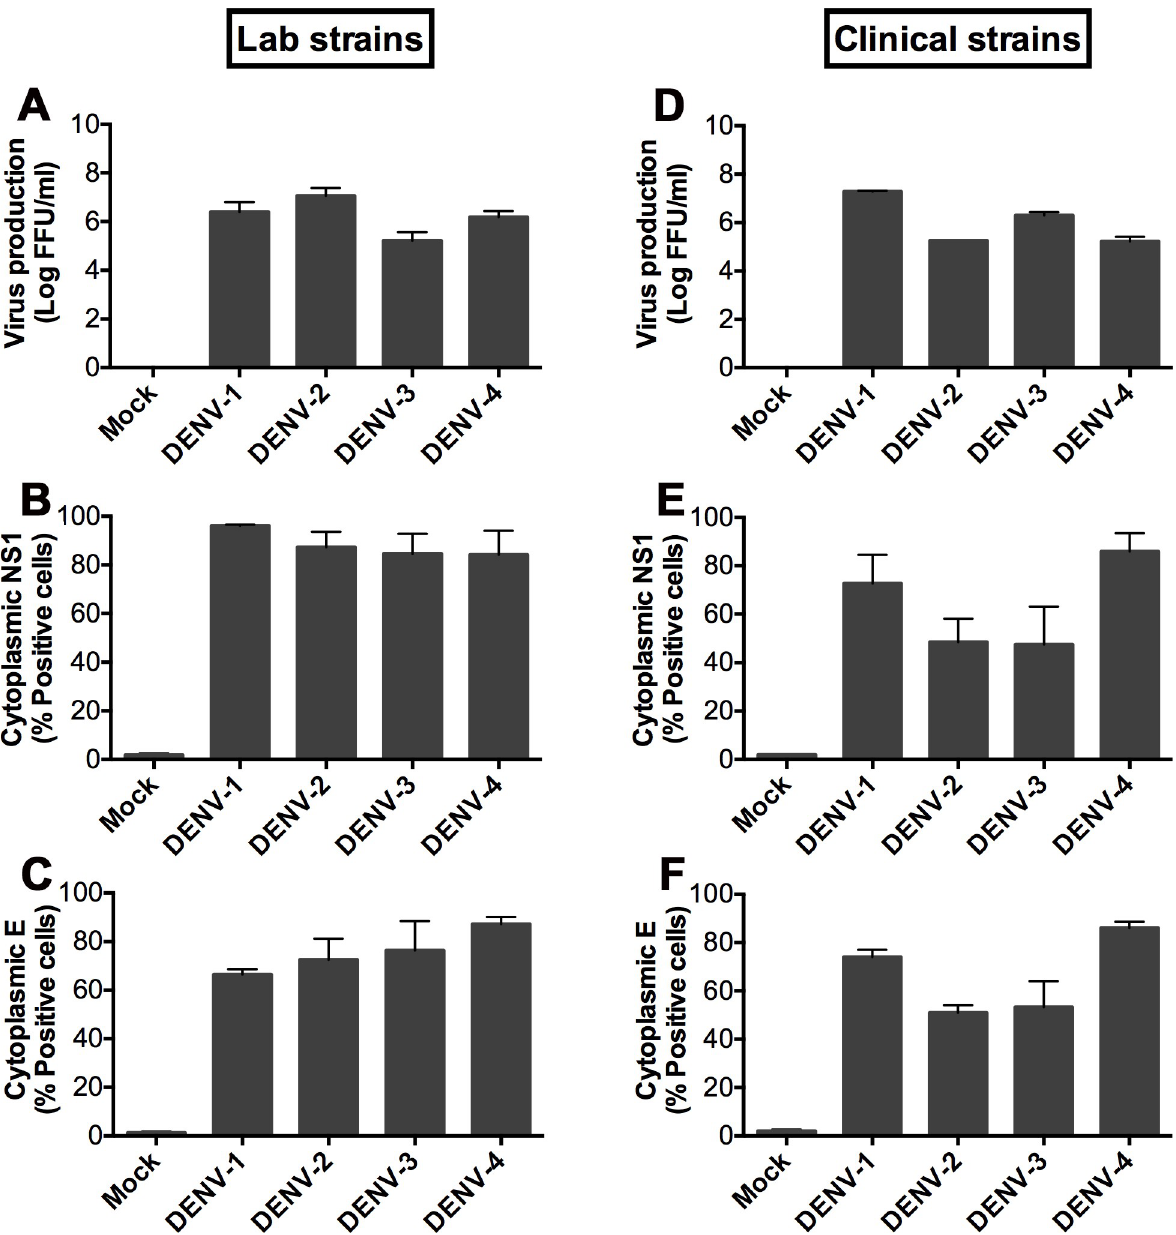
Fig 3. Productive infection of all four DENV serotypes, both laboratory and clinically isolated strains, in imHC. imHC were infected with four different DENV serotypes (DENV-1, DENV-2, DENV-3 and DENV-4) of either laboratory ( A , B and C ) or recently isolated clinical strains ( D , E and F ) at MOI of 0.1 for 48 h. The cell culture supernatants were subjected to the FFU assay to determine the levels of viral production ( A and D ). The percentages of DENV-infected cells were analyzed by immunofluorescent staining of cytoplasmic NS1 ( B and E ) and envelope ( C and F ) proteins, followed by flow cytometry. Data are presented as mean ± S.D. of values from three independent